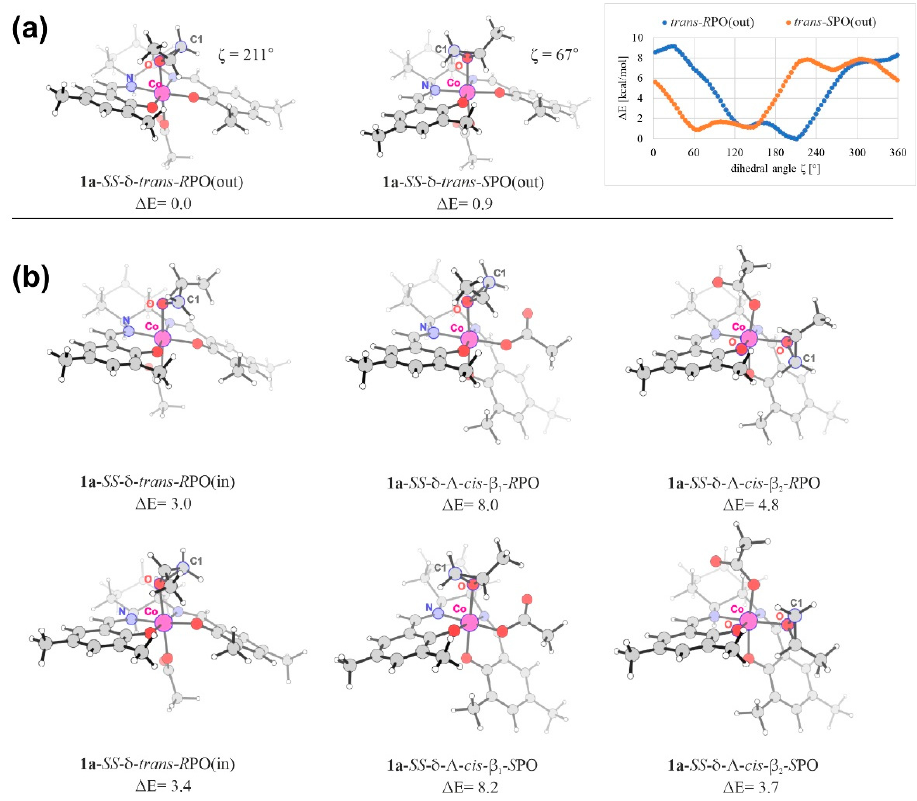
Figure 7. Part (a): Optimized minimum-energy molecular structures of 1a - SS - δ - trans - R PO(out) and 1a - SS - δ - trans - S PO(out) along with the corresponding electronic-energy profiles for the rotation of the epoxide with respect to the Co(III)-salcy fragment. Dihedral angle ζ is defined by four atoms labelled in each structure (C1 (PO) –O (PO) –Co–N or C1 (PO) –O (PO) –Co–O angle marked in blue). Part (b): Minimum-energy molecular structures of 1a for remaining stereoisomers considered. Relative electronic-energy values ( ∆ E ) given in Table 1. Relative electronic ‐ energy and free ‐ energy values ( Δ E and Δ G , in kcal/mol) of the lowest ‐ energy R PO and S PO epoxide complexes within each group of considered stereoisomers of 1a and 1b . Dihedral angle ζ (in o ) describes orientation of epoxide relative to the Co(III) ‐ salcy fragment,